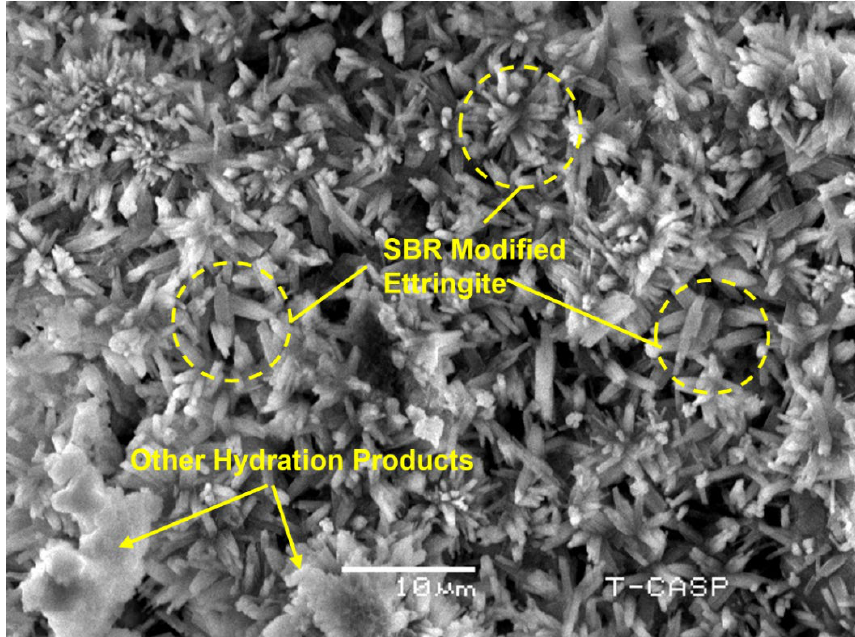
Figure 8. SEM Image of Mortar with 10% SBR. (Highly dense SBR wrapped ettringites needles).